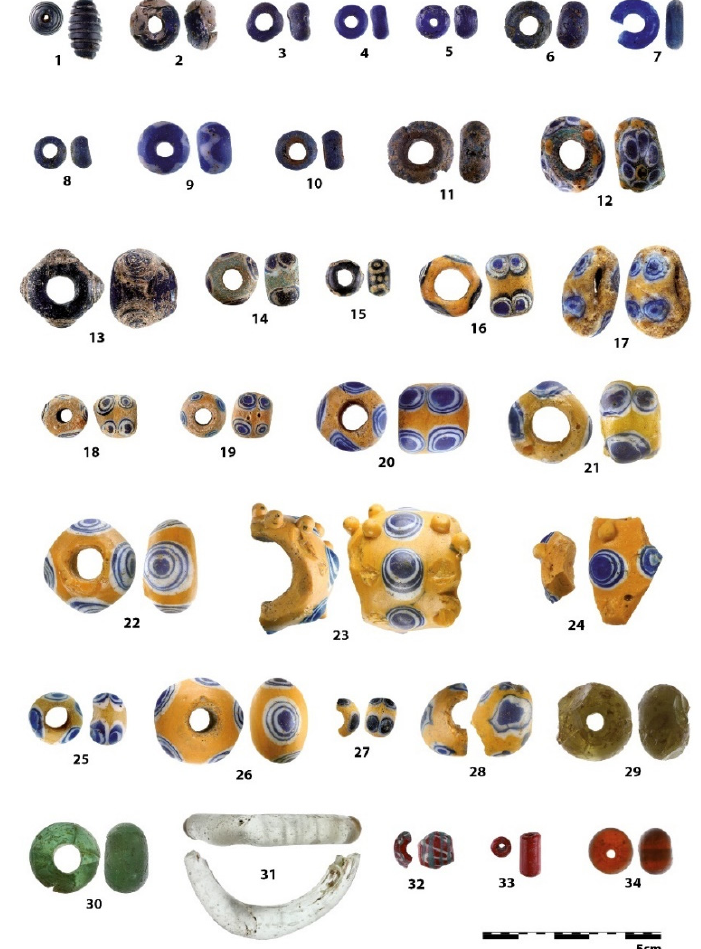
Figure 2. Analyzed glass beads with sample numbers (see Table 1 for Inv. No. and site information). National Museum in Prague collection, Archaeological Institute in Prague collection, UAPPS Č collection, Roztoky Museum collection. Photo Martina Koša ř ová. Table 1. List of the analyzed glass beads.